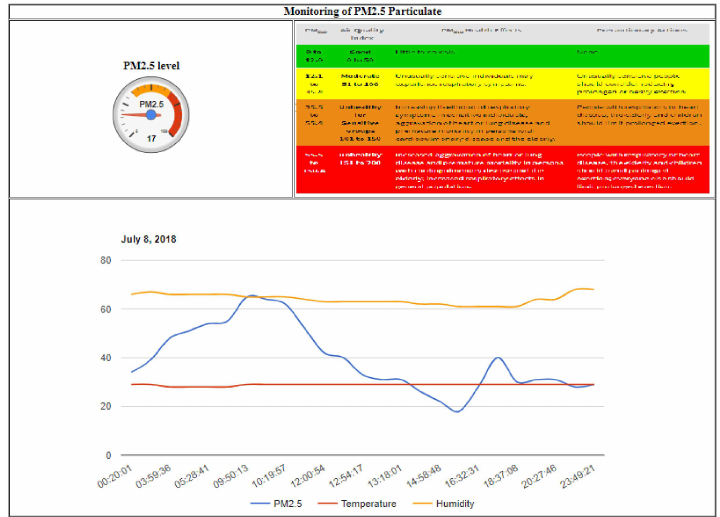
Fig. 8 The dashboard system for monitoring air pollution